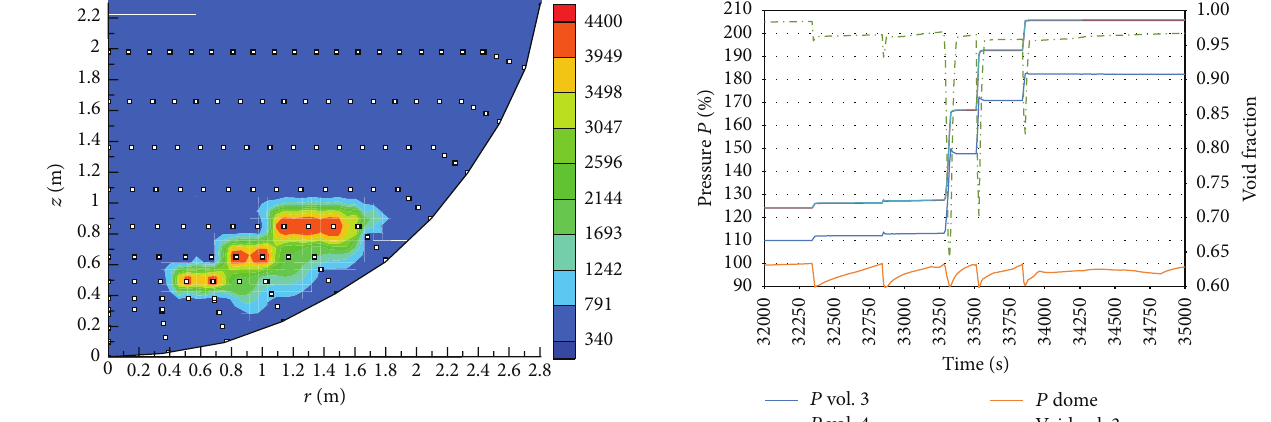
Figure 14: Debris bed temperature distribution on RPV wall at the time of reaching the maximum value.